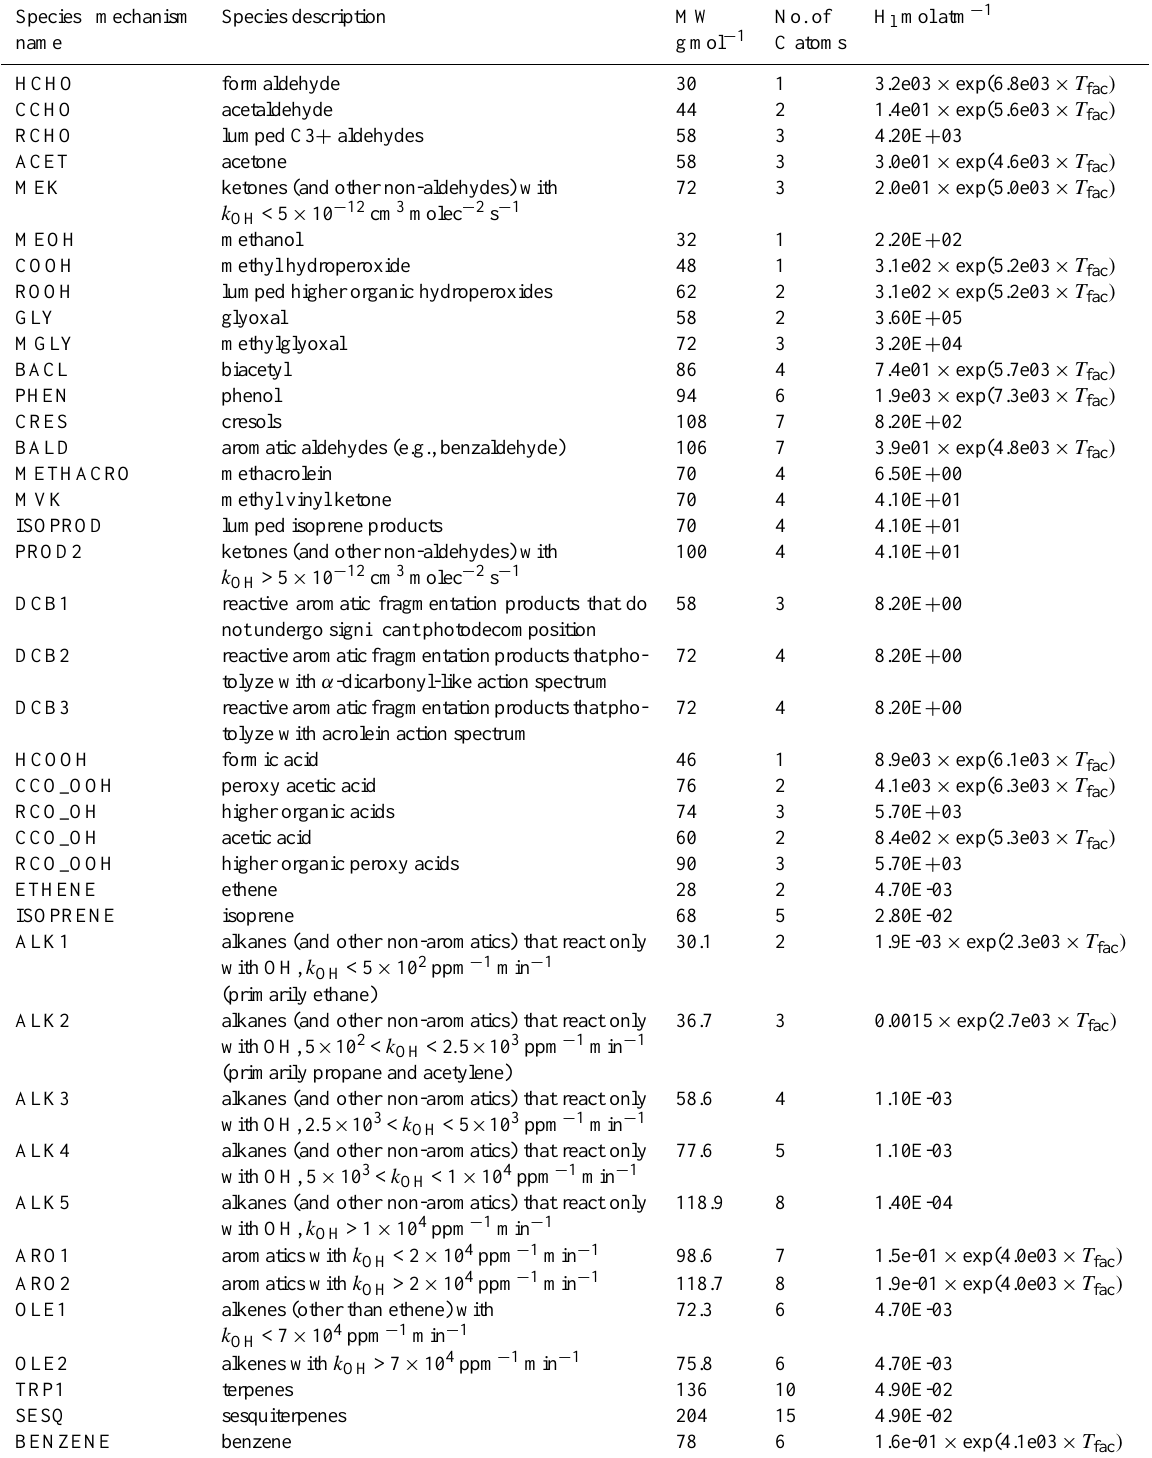
Table 1. Values used in MGLY equiv calculations for gas-phase organic species in the SAPRC99 gas-phase chemical mechanism as applied in